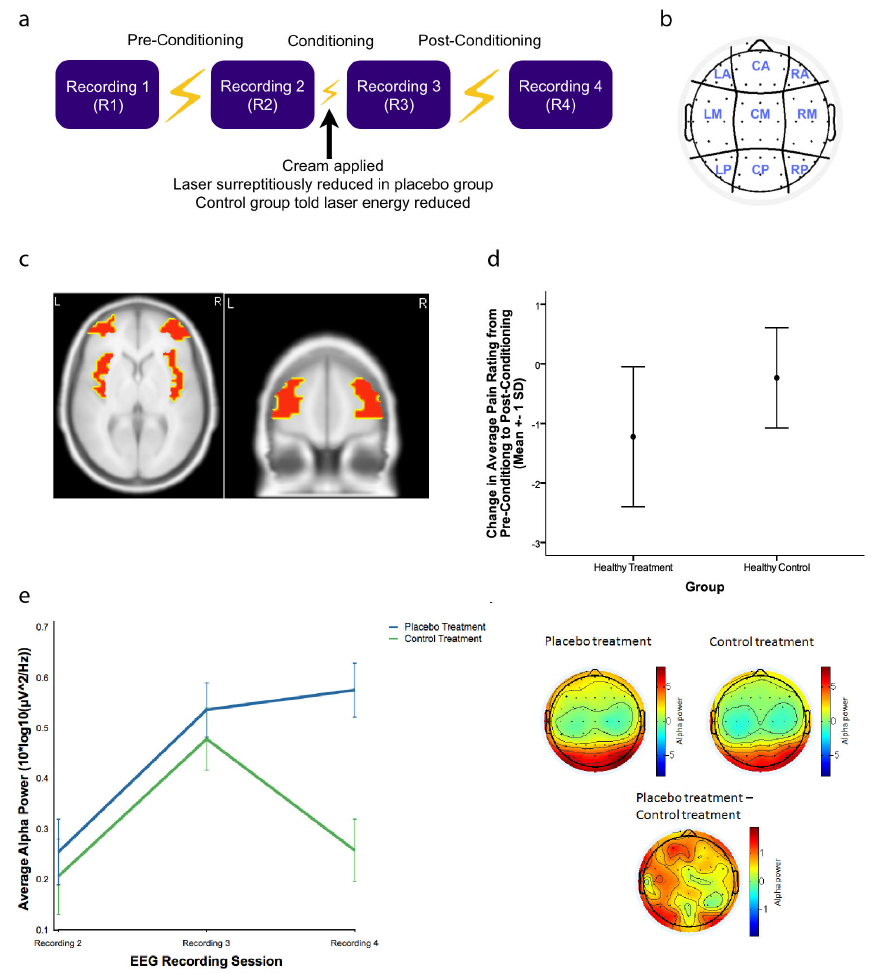
Figure 1. Experimental design, behavioral and event-related potential results. ( a ) Summary of the experimental placebo procedure used in the present study . Three blocks of repetitive laser stimulation (pre-conditioning, conditioning, and post- conditioning) were administered to the right forearm. During the pre-conditioning block, the laser stimulation was moderately painful. Prior to the conditioning block, a placebo analgesic cream was applied to the right forearm, over the area of laser stimulation. During the conditioning block, the laser energy was surreptitiously reduced to non-painful levels in the placebo group, to condition participants to believe the cream possessed analgesic properties. Participants in the control group were informed that the laser energy was reduced. Moderately painful laser stimulation was resumed during the post-conditioning block. Four resting EEG recordings were also taken during the procedure (blue) to monitor changes in alpha activity. ( b ) Topographical map of the scalp . To aid statistical analysis, we averaged the power data across electrodes in nine scalp regions. This gave us one value for alpha power in each region during each recording. Abbreviations: LA, left anterior; LM, left middle; LP, left posterior; CA, central anterior; CM, central middle; CP, central posterior; RA, right anterior; RM, right middle; RP, right posterior. ( c ) Mask for region of interest analysis . The regions in this mask encompass the bilateral dorsolateral prefrontal cortex (DLPFC) (brodmann areas 9, 10 and 46) and bilateral insulae. ( d ) Pain reduction from the pre-conditioning block to the post-conditioning block in each group . The plot shows the mean with standard deviation bars of pain reduction in each group. The placebo treatment group demonstrated significantly increased pain reduction compared with the control treatment group ( p < 0.001). Points lying outside of the whiskers represent outliers. ( e ) The changes in alpha power over the course of the procedure . Each value represents alpha power averaged across all electrodes. This has been compared with the average alpha power in recording 1 for each group. In this way, we can see how alpha power has changed from the first recording. The placebo treatment group (blue) demonstrated increased alpha power following conditioning (from recording 3 to recording 4), while alpha power decreased in the control treatment group (green) over the same period. The change in alpha power following conditioning between the placebo and control group differed significantly. ( f ) Topographic maps of alpha power in recording 4 (R4) . Maps are shown of alpha power in each group, and the difference between the groups. Alpha power is in units of 10*log (µV 2 /Hz). 10 doi: 10.1371/journal.pone.0078278.g001 PLOS ONE |